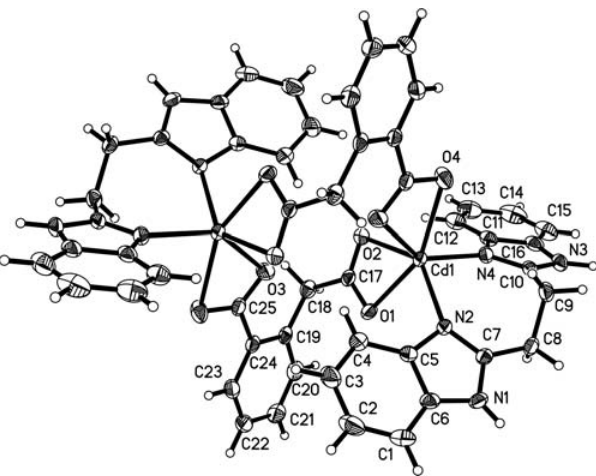
Table 1. Data collection and handling.